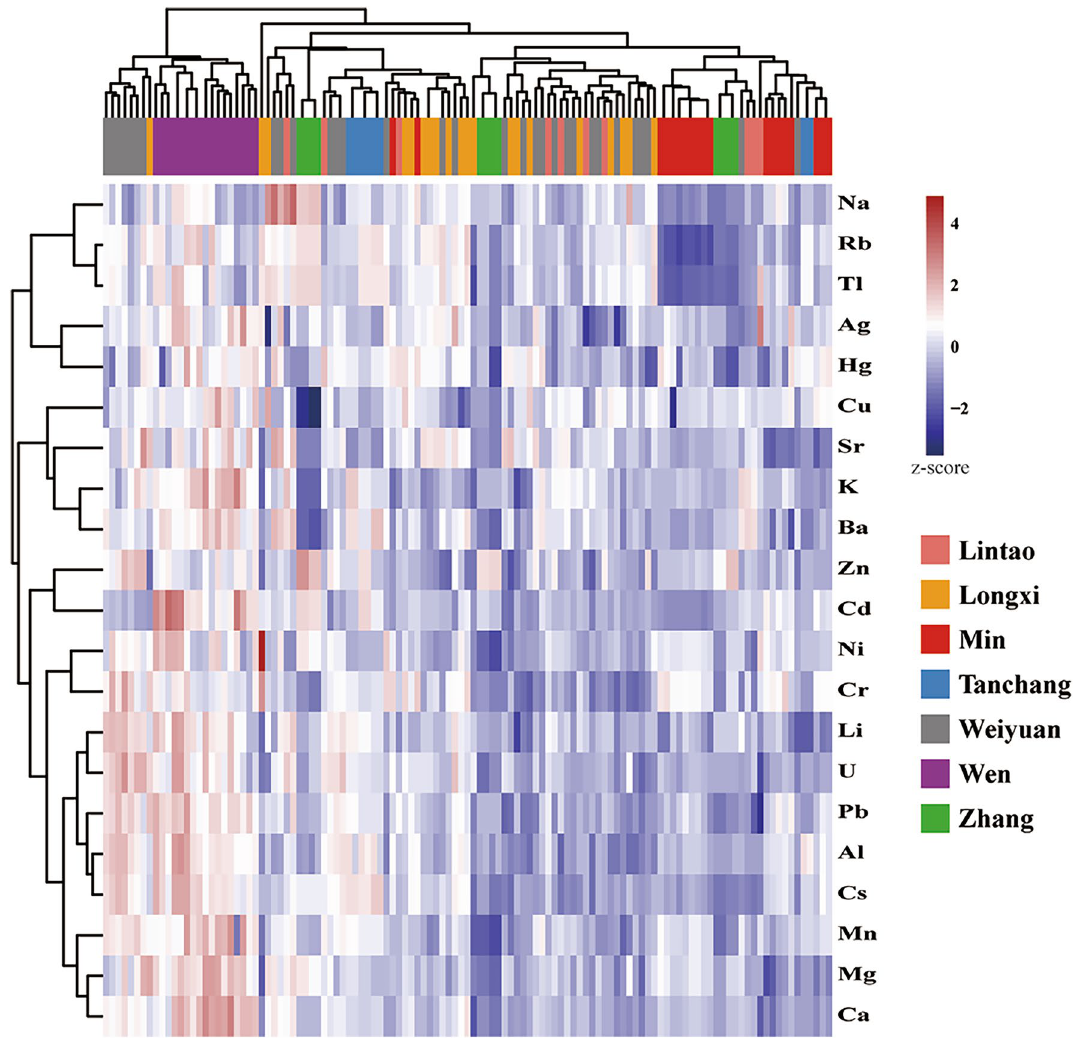
Figure 2. Cluster heatmap showing the element concentrations in Codonopsis Radix samples. Color scale displays the range of concentrations from low (blue) to high